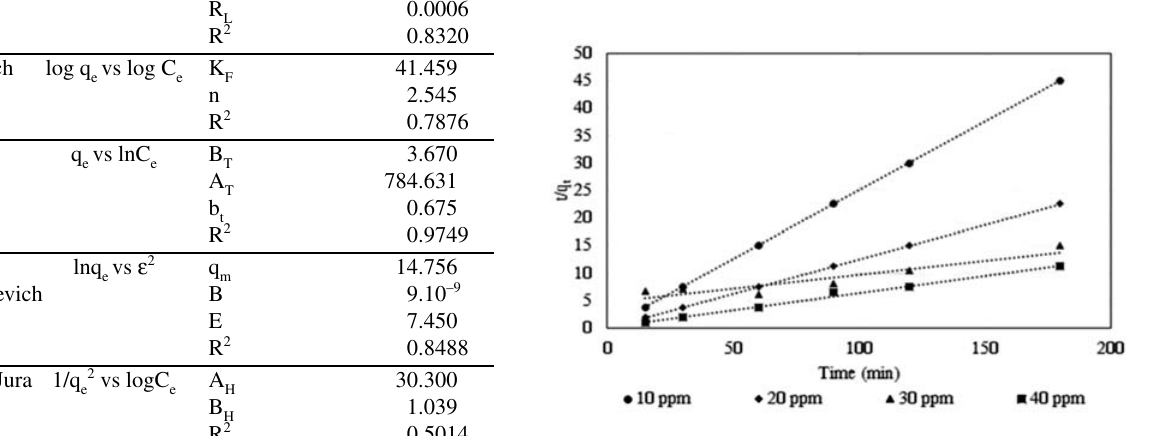
Fig. 4: Pseudo – second order kinetic plots